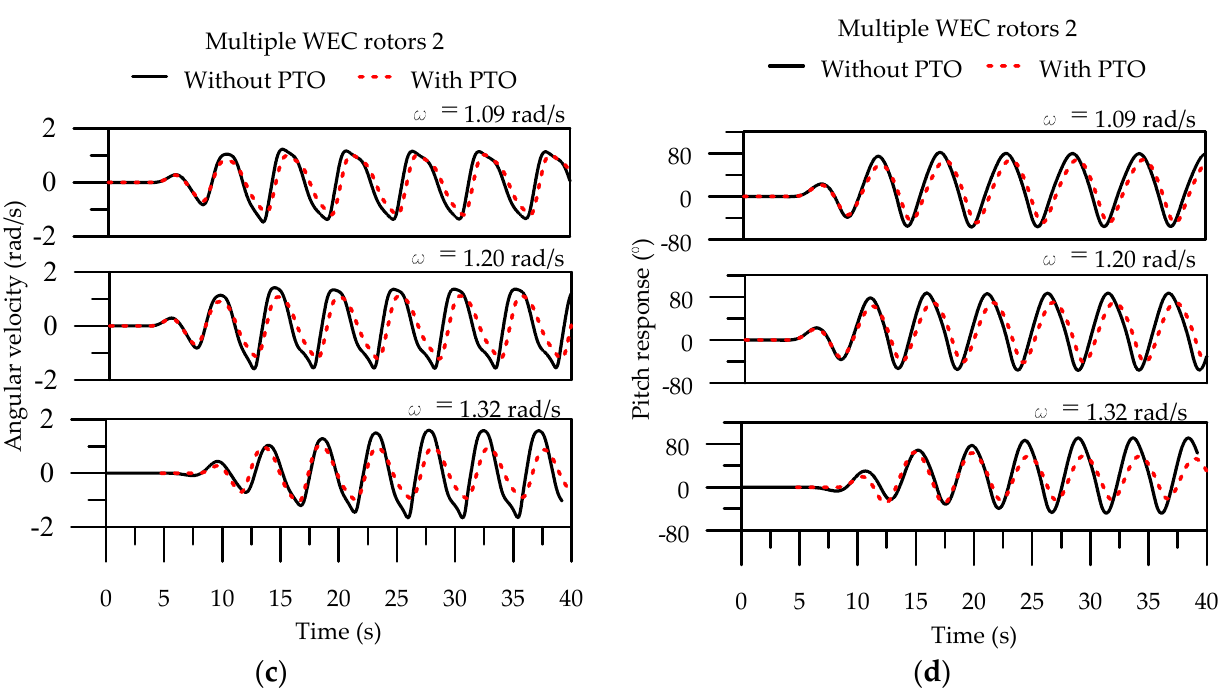
Figure 11. Numerical comparison of multiple WEC rotors with and without PTO for different wave frequencies: ( a ) angular velocity of multiple WEC rotors 1 and 3, ( b ) pitch response of multiple WEC rotors 1 and 3, ( c ) angular velocity of multiple WEC rotor 2, and ( d ) pitch response of multiple WEC rotor 2.